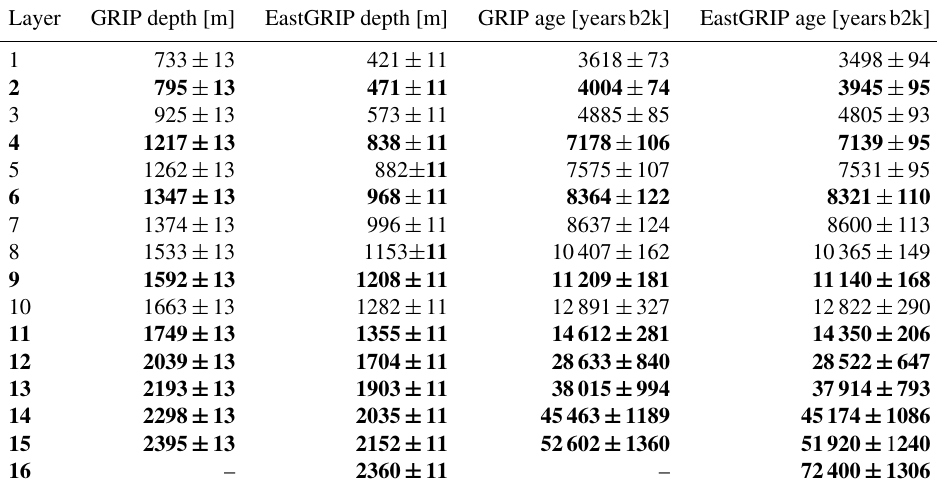
Table 3. Characteristics of the traced isochrones connecting the GRIP and EastGRIP ice-core sites. Displayed depths and ages are the average over the three flow lines. Depth uncertainties include the uncertainty related to the picking process and to the radar range resolution. Age uncertainties are related to the GICC05 timescale uncertainties and isochrone depths. Figure 7d illustrates the depth and climatic context of these layers in the EastGRIP ice core, identified with the corresponding layer numbers. The bold layers and the EastGRIP ages were used for the Monte Carlo inversion and are illustrated with a consistent colour code in Figs. 4, 5 and